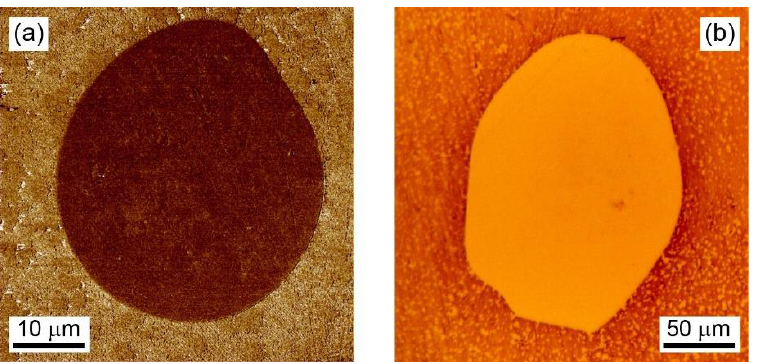
Figure 1. Images of an isolated domain on the polar surface of a nominally pure CVO single crystal: ( a ) PFM, ( b ) optical microscopy. ( a ) PFM, ( b ) optical